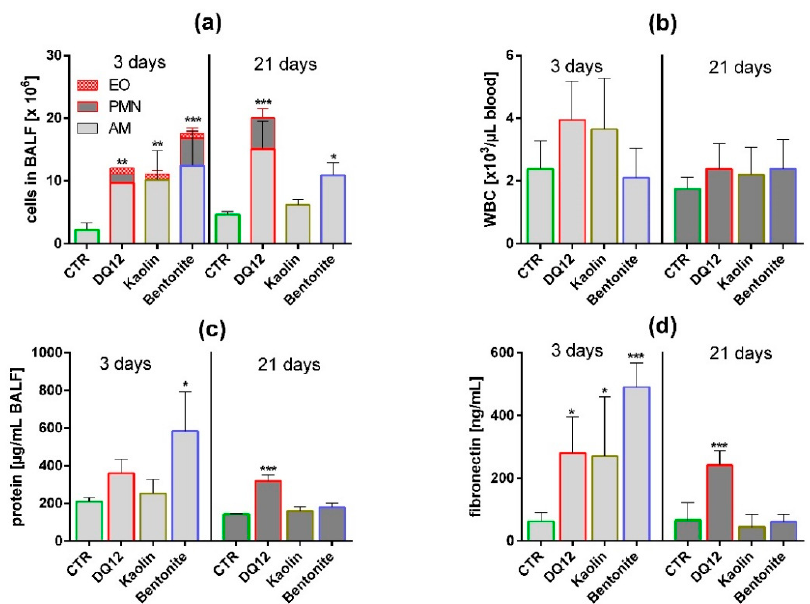
Figure 4. In vivo e ff ects of kaolin, bentonite, and quartz DQ12 on lung and peripheral blood. Analysis of the bronchoalveolar lavage fluid (BALF) and of white blood cells (WBC) in peripheral blood (5 animals per group) 3 and 21 days after intratracheal instillation of 1.2 mg (all particles). The vehicle control (CTR) received 0.5 mL H 2 O only. ( a ) Di ff erential cell counts revealed changes in the numbers of eosinophils (EO), neutrophilic granulocytes (PMN), and alveolar macrophages (AM). ( b ) Number of WBC in citrate blood. ( c ) Concentration of total protein in BALF. ( d ) Concentration of fibronectin in BALF. *: p < 0.05, **: p < 0.01, ***: p < 0.001.